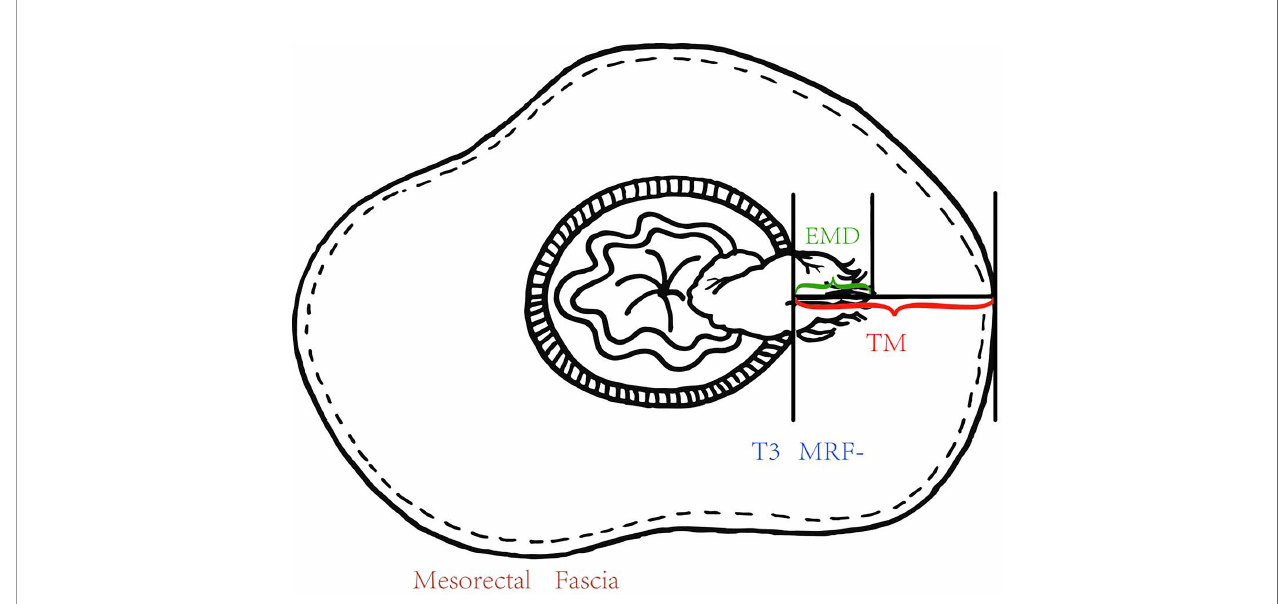
phased-array body coil. Sagittal T2-weighted (T2W) fast